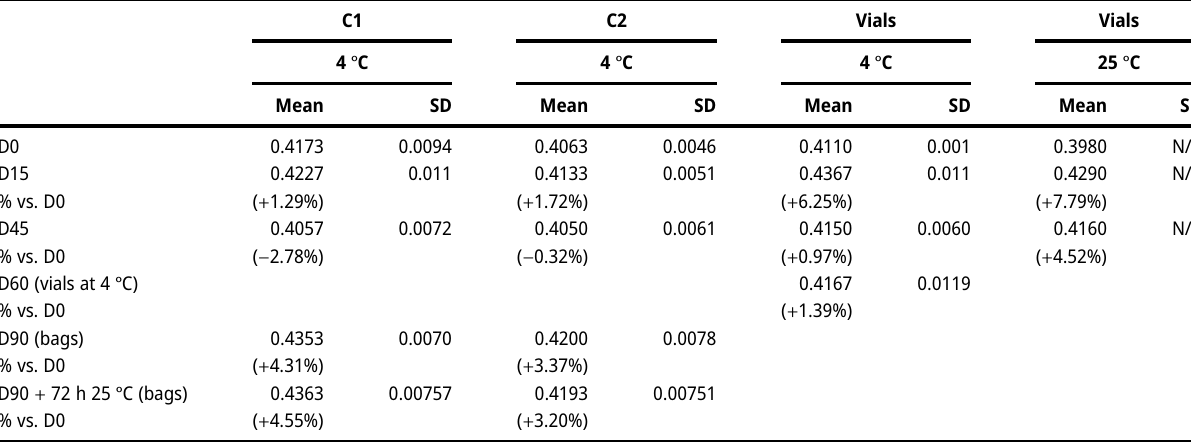
Table  : Absorbances at  nm as a function of time.